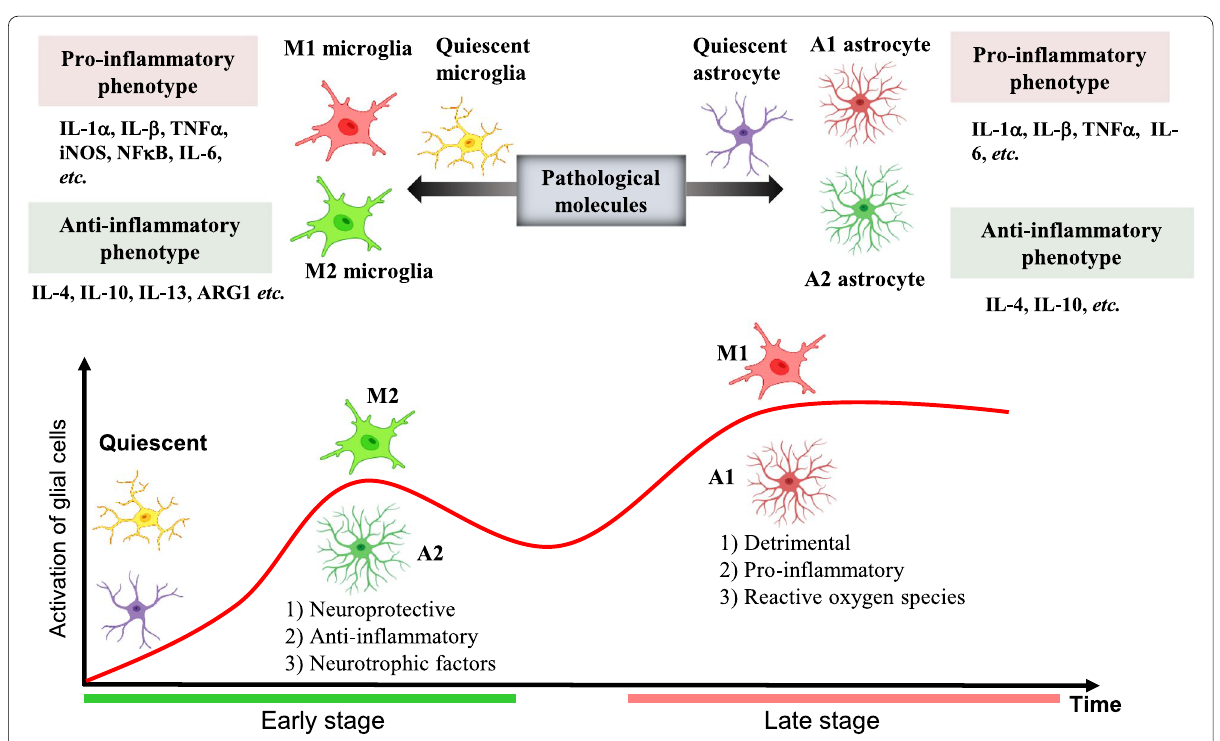
Fig. 5 Activation and polarization of microglia in AD. The M1 phenotype produces pro‑inflammatory cytokines (i.e., IL‑1β, TNF‑α, NFκB, and IL‑6), exacerbating AD progression. However, the M2 phenotype release anti‑inflammatory cytokines (i.e., IL‑4, IL‑10, and IL‑13), providing neuroprotective effects in AD. Similar to microglia, astrocytes are classified into A1 neurotoxic and A2 neurotrophic/neuroprotective phenotypes. In the early stage of AD, quiescent glial cells are activated to the A2 and M2 phenotypes and transformed into A1 and M1 phenotypes at the late stage of AD